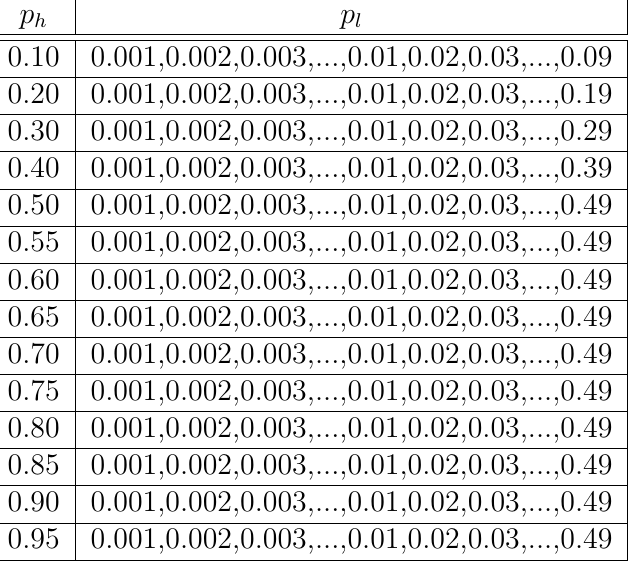
and p in the experimental performance evaluation of Algorithm 1. h l